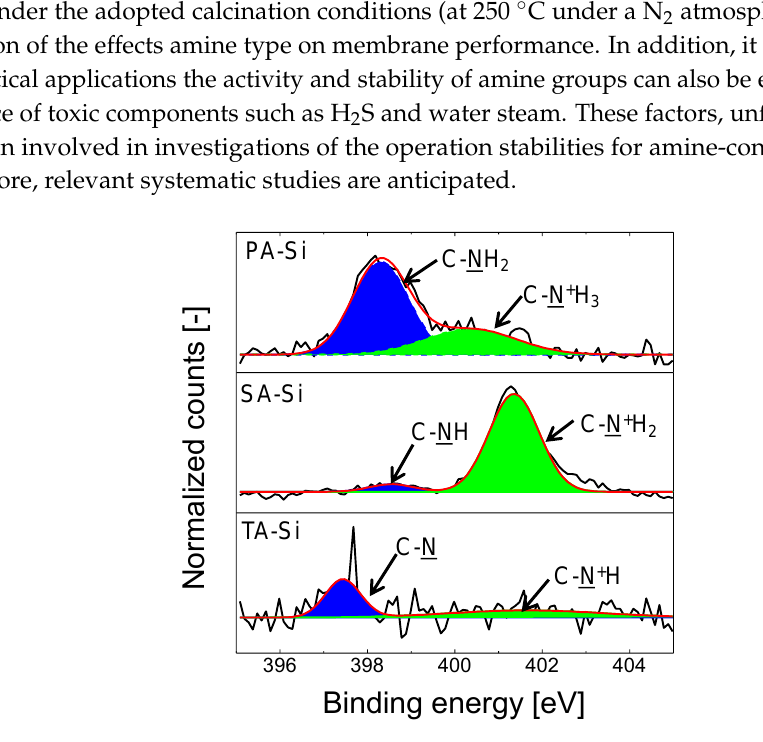
Figure 5. The N1s spectra of amine-silica xerogel powders fired at 250 °C under N 2 (black line, original peak; red line, fitted peak). Reproduced from ref. [22] with permission. Copyright (2017), Elsevier . Table 3. Atomic composition of amine-silica xerogel powders fired at 250 °C estimated by XPS measurement. Reproduced from ref. [22] with permission. Copyright (2017), Elsevier .